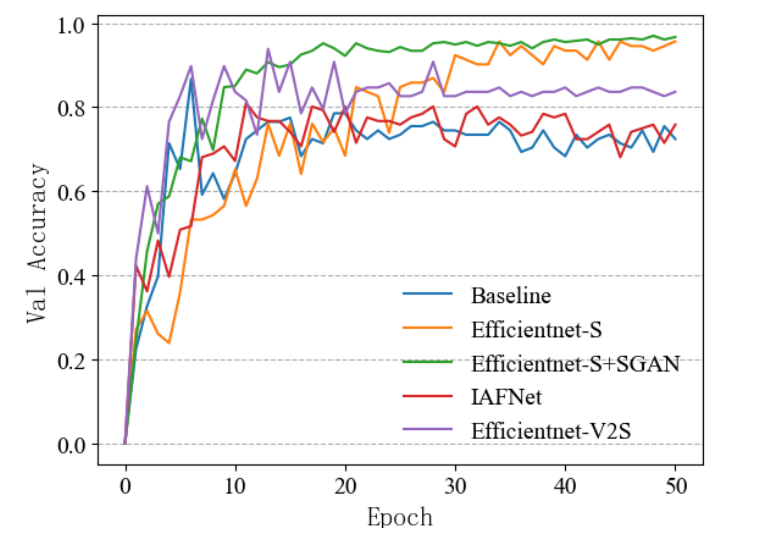
Figure 16. The validation accuracy for different